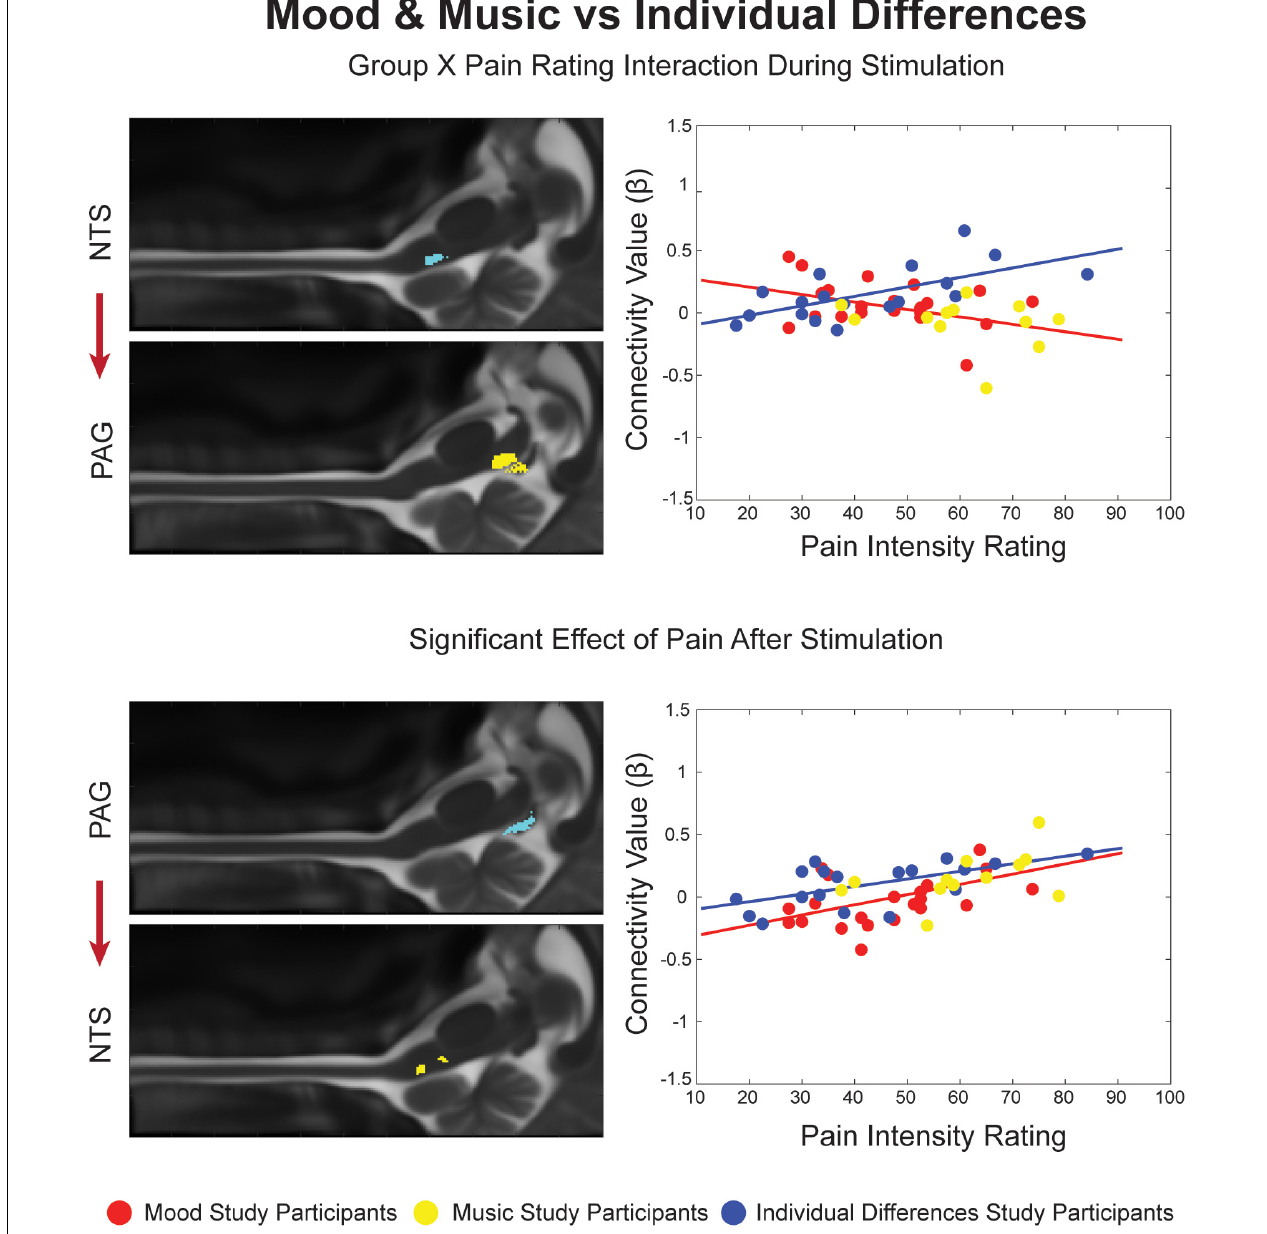
FIGURE 3 | Significant Group X Pain Rating ANCOVA results for the Mood and Music condition and Individual Differences. Regions are highlighted and labeled on sagittal slices of the anatomy (left) . The figure legend refers to the plotted results of the ANCOVA (right) with red and yellow points representing Mood and Music study participants, respectively, corresponding to the red trendline as a combined group. The blue points and trendline represent the separate Individual Differences